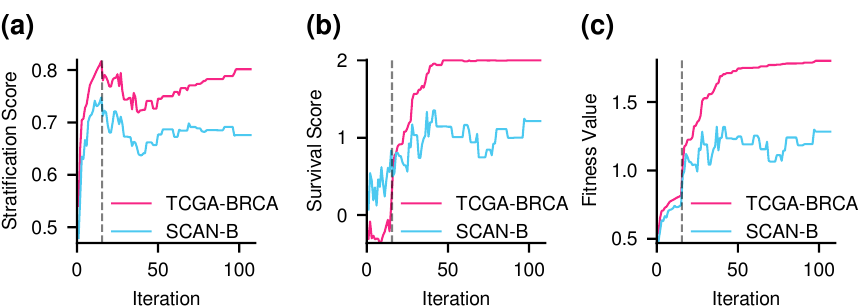
Figure 4. Scores of the best chromosome in each iteration. TCGA-BRCA is a discovery data set, and SCAN-B is a validation data set. The black dashed line stands for the point at which the survival score started to be calculated. ( a ) The stratification score tended to increase considerably before the survival score was considered. As the survival score started to be calculated, the stratification